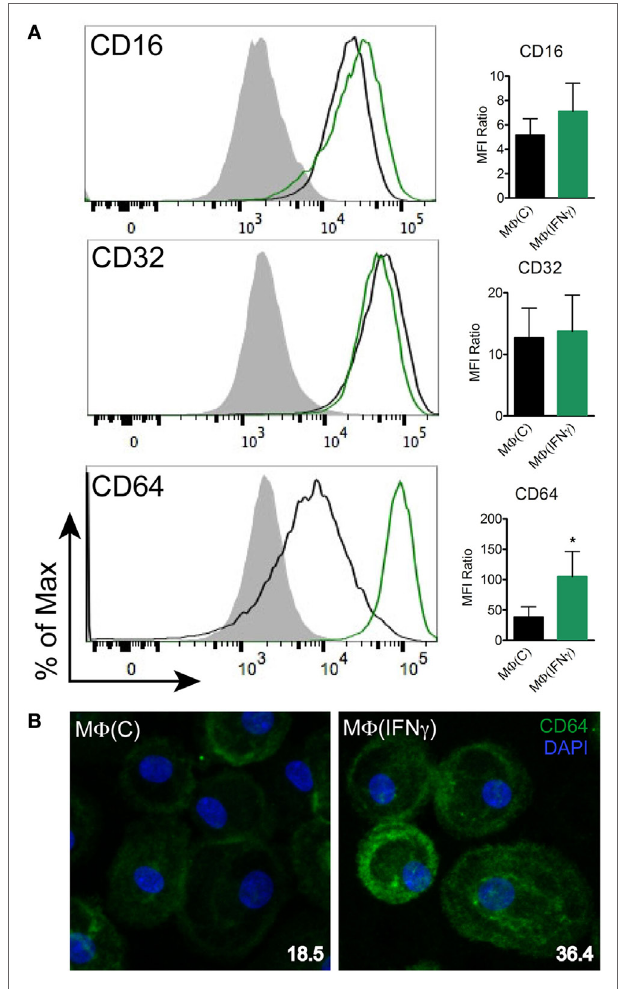
FigUre 6 | CD64 expression on human macrophages. M Φ (C)s (black) and M Φ (IFN γ )s (green) from the same participant were assessed to determine the expression level of (a) Fc γ receptors (Fc γ Rs): CD16, CD32, and CD64 by flow cytometry. The filled gray histograms indicate the isotype control. Histograms are representative of a minimum of four independent experiments. Data of the mean fluorescence intensity (MFI) ratio ± the SD were analyzed for statistical significance using the paired Student’s t -test, * p -value of < 0.05. (B) M Φ (C)s and M Φ (IFN γ )s were incubated in eight-well chamber slides and expression of CD64 (green) was determined by IFA with mouse anti-human CD64 (clone 10.1) antibody. Representative confocal micrographs of CD64 expression levels shown as a composite of 10 consecutive Z-stack planes. CD64 MFI values (inset in bottom right) were calculated using